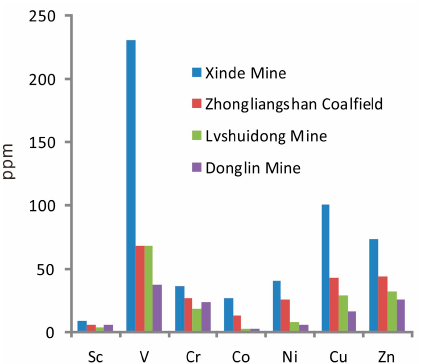
Figure 8. Concentration comparison of Sc, V, Cr, Co, Ni, Cu and Zn in the Xinde Mine, Zhongliangshan Coalfield, Lvshuidong Mine and Donglin Mine. The data of the Xinde, Lvshuidong and Donglin are from Dai et al. and Chen et al., respectively [8,14].